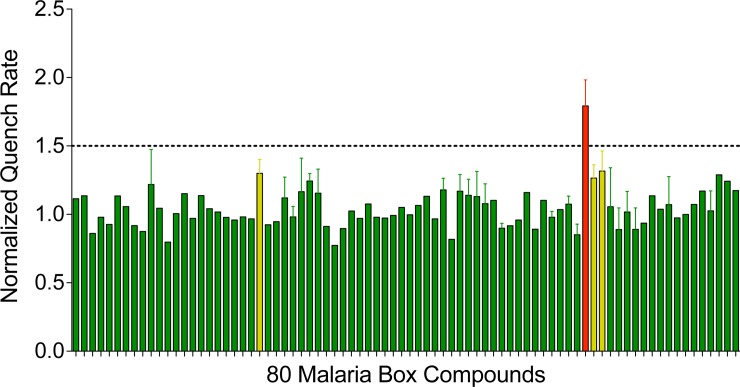
Four Malaria Box compounds have statistically significant bilayer effects.80 Malaria Box compounds were tested at 5 μM, the order of the compounds is A2 … A11, B2 … B11, etc. The four Malaria Box compounds that perturb the bilayer are MMV007384 (red bar, q5 = 1.79, p<0.01), and from L to R (amber bars): N-{4-[(4-methyl-1-piperidinyl)methyl]phenyl}-1H-pyrrolo[3,2-h]quinoline-2-carboxamide, MMV020549, q5 = 1.3, p<0.05); N-{4-[(4-ethyl-1-piperazinyl)methyl]phenyl}-1H-pyrrolo[3,2-h]quinoline-2-carboxamide, MMV020548, q5 = 1.27, p < .05); and 2-{[1-(2,4-dimethoxyphenyl)-1H-imidazol-2-yl]sulfanyl}-N-(2,5-dimethylphenyl)acetamide MMV019258, q5 = 1.32, p < .05). Error bars depict S.E.M. Unpaired, two-tailed t-tests were performed in comparison to control.